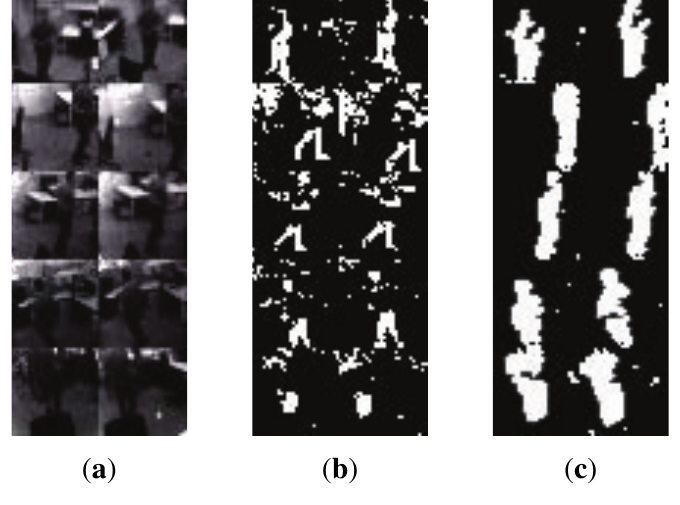
Figure 7. Left to right: ( a ) original image; ( b ) foreground detection by ViBe; ( c ) foreground detection by our correlation-based